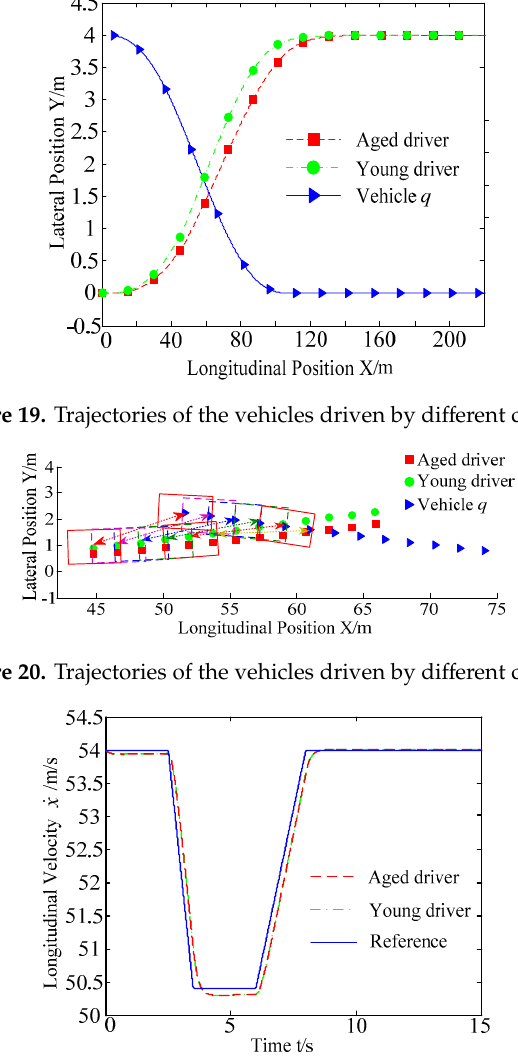
f δ Figure 22. Front wheel angle of vehicle p under different handling characteristics. Figure 23. Yaw angle of vehicle p under different handling characteristics.